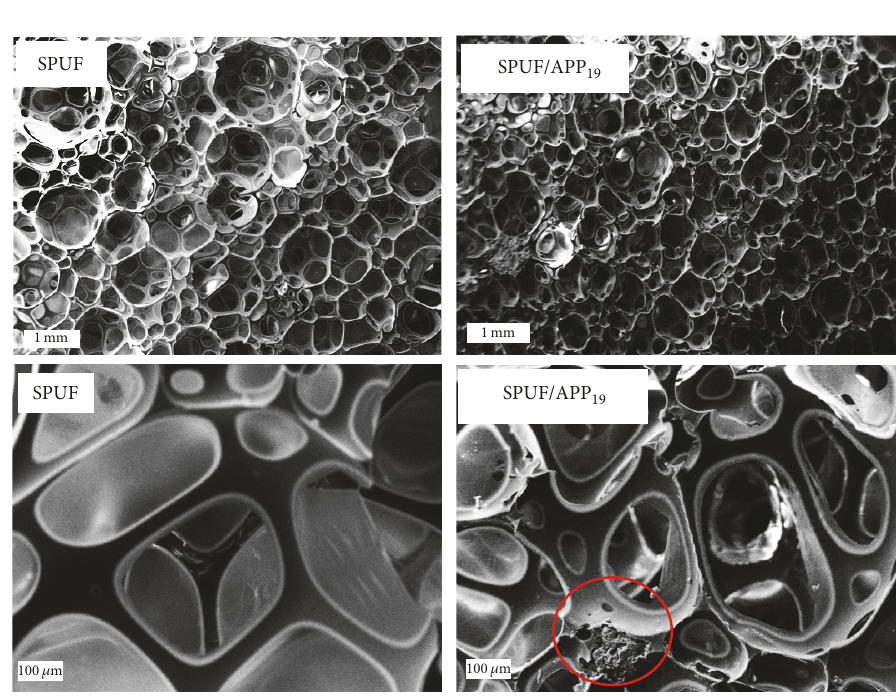
Figure 6: The SEM micrographs of SPUF and SPUF/APP 19